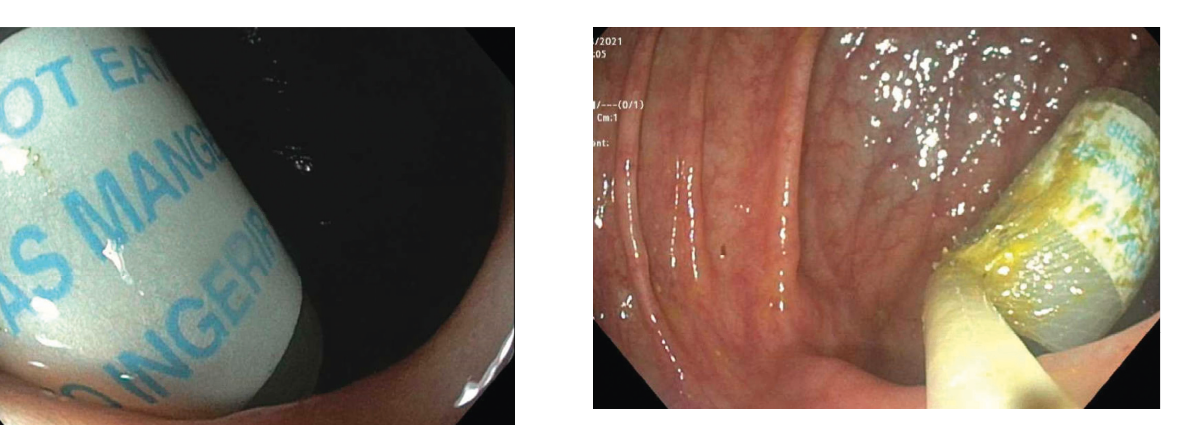
Figure 3: Foreign body removal using Roth Net.